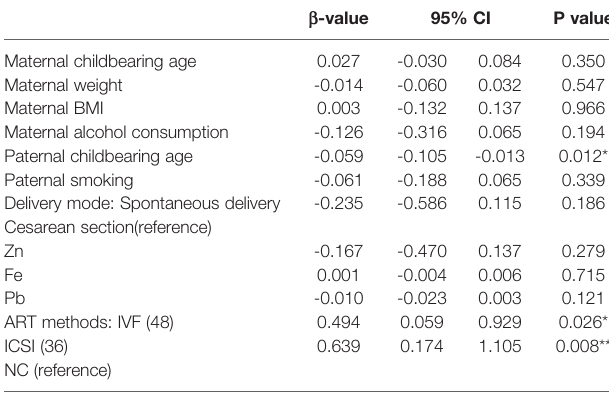
TABLE 3 | Multiple linear regression analysis of bone mineral density- ART methods.